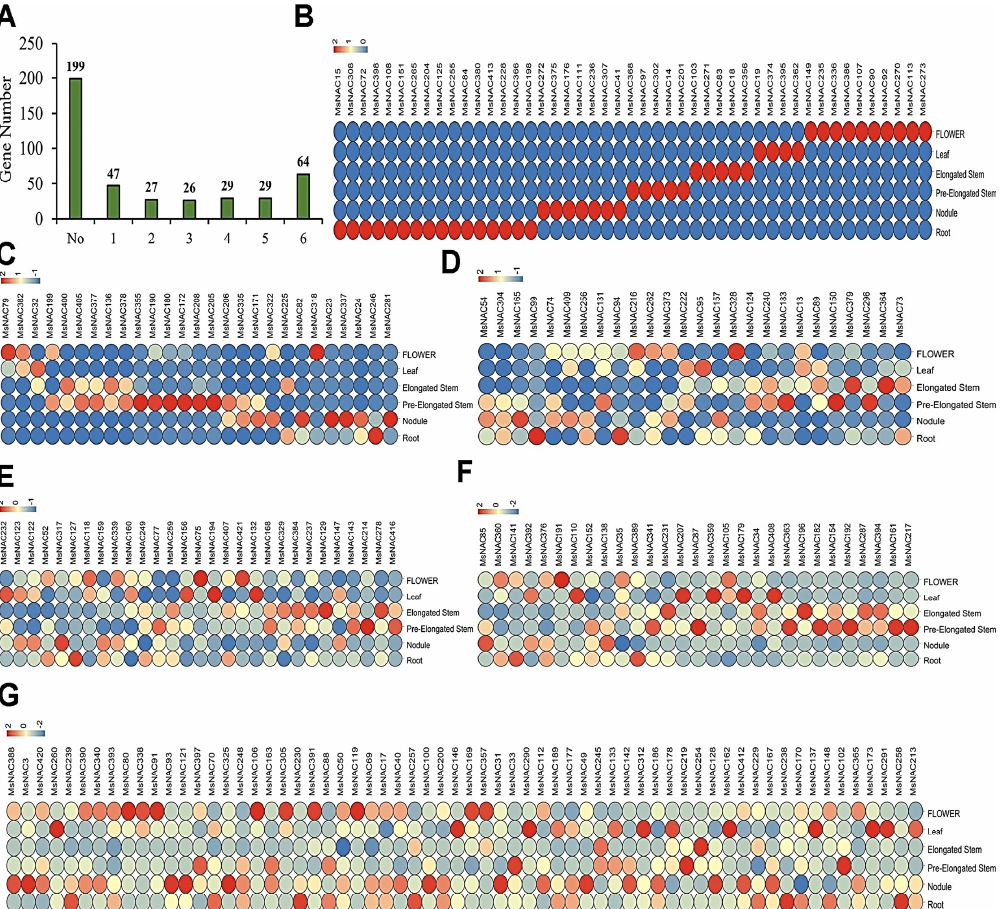
Figure 5. Expression analysis of MsNAC genes in different tissues (flower, leaf, elongated stem, pre- elongated stem, nodule and root). ( A ), Statistical analysis of the number of MsNAC genes expressed in different tissues. ( B ), The 47 MsNAC genes expressed in only one tissue. ( C ), The 27 MsNAC genes expressed in two tissues. ( D ), The 26 MsNAC genes expressed in three tissues. ( E ), The 29 MsNAC genes expressed in four tissues. ( F ), The 29 MsNAC genes expressed in five tissues. ( G ), The 64 MsNAC genes expressed in six tissues. The expression levels were normalized by row using the Z-Scores algorithm. The color scale at the top of the heatmap refers to the relative expression level, and the color gradient from blue to red presents an increasing expression